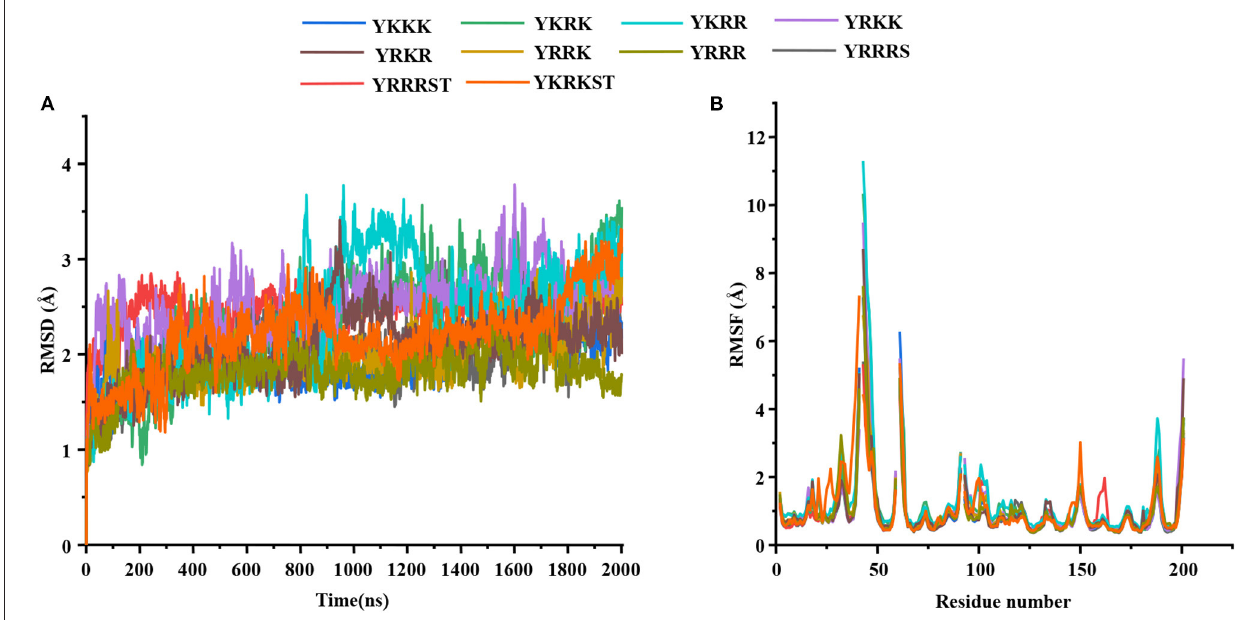
FIGURE 1 | (A) The root mean square deviations (RMSD) (Å) of the C α atoms of the protease and (B) the root mean square fluctuations (RMSF) (Å) of different residues of the protease in different protein-peptide complexes.